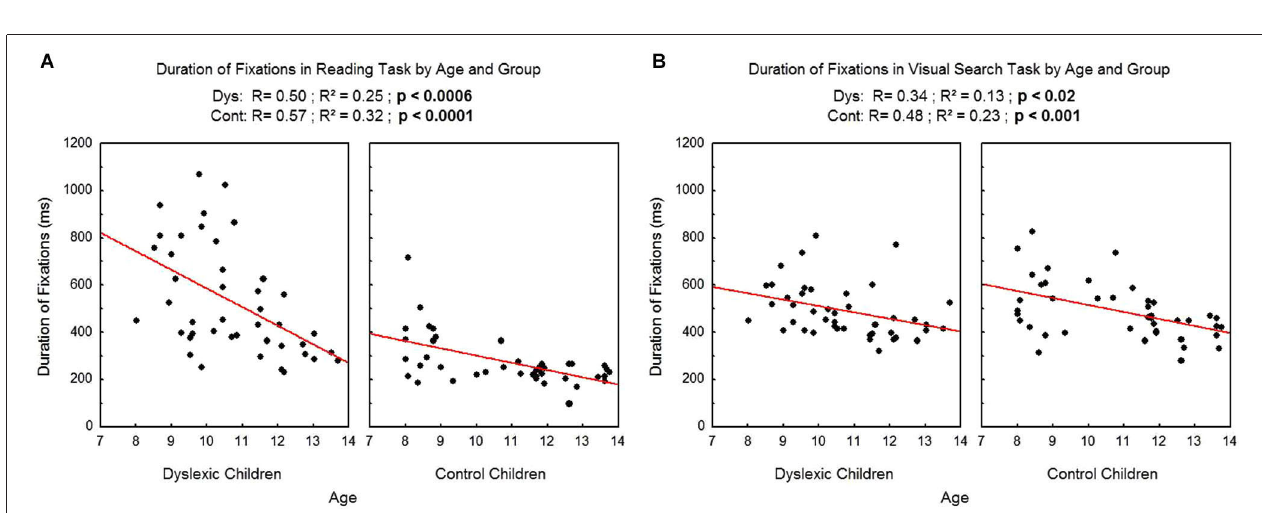
FIGURE 3 | Duration of fixations during reading (A) and during visual search (B) for the both groups of subjects . Lines represent the corresponding